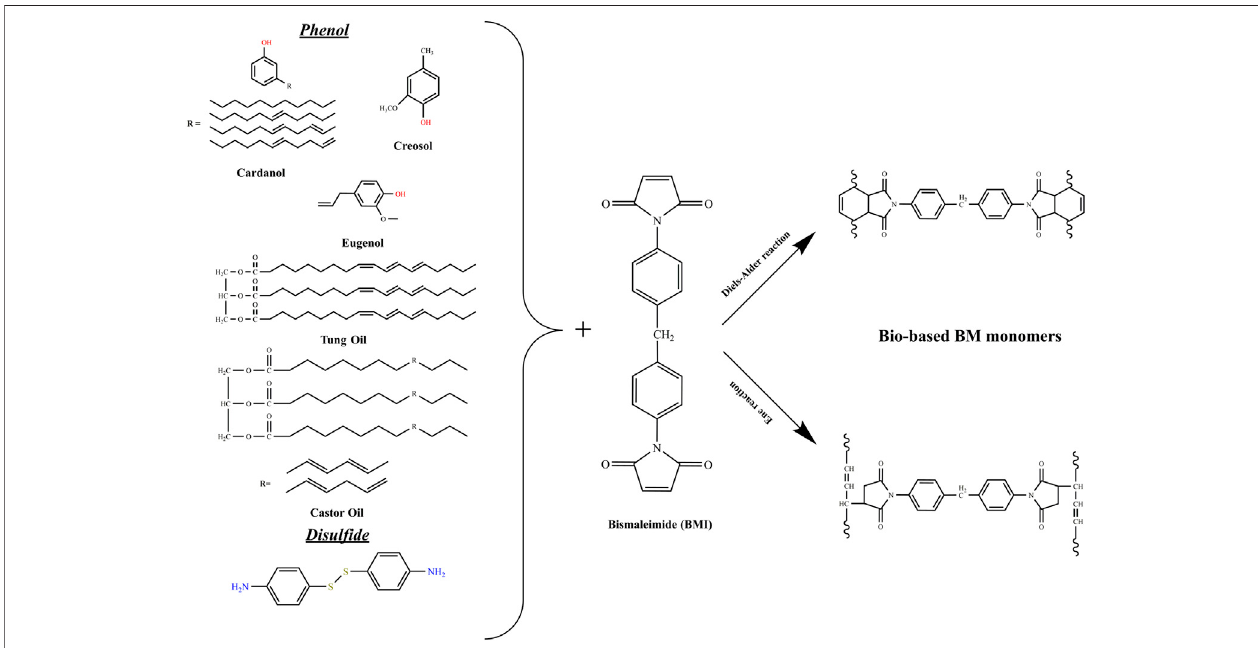
FIGURE 3 | Synthetic routes of bio-based bismaleimide